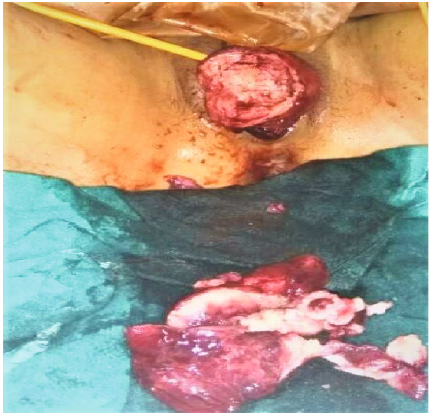
Figure 3: Picture after completion of vaginal myomectomy of the inverted uterus in piecemeal and before repair of myometrium and